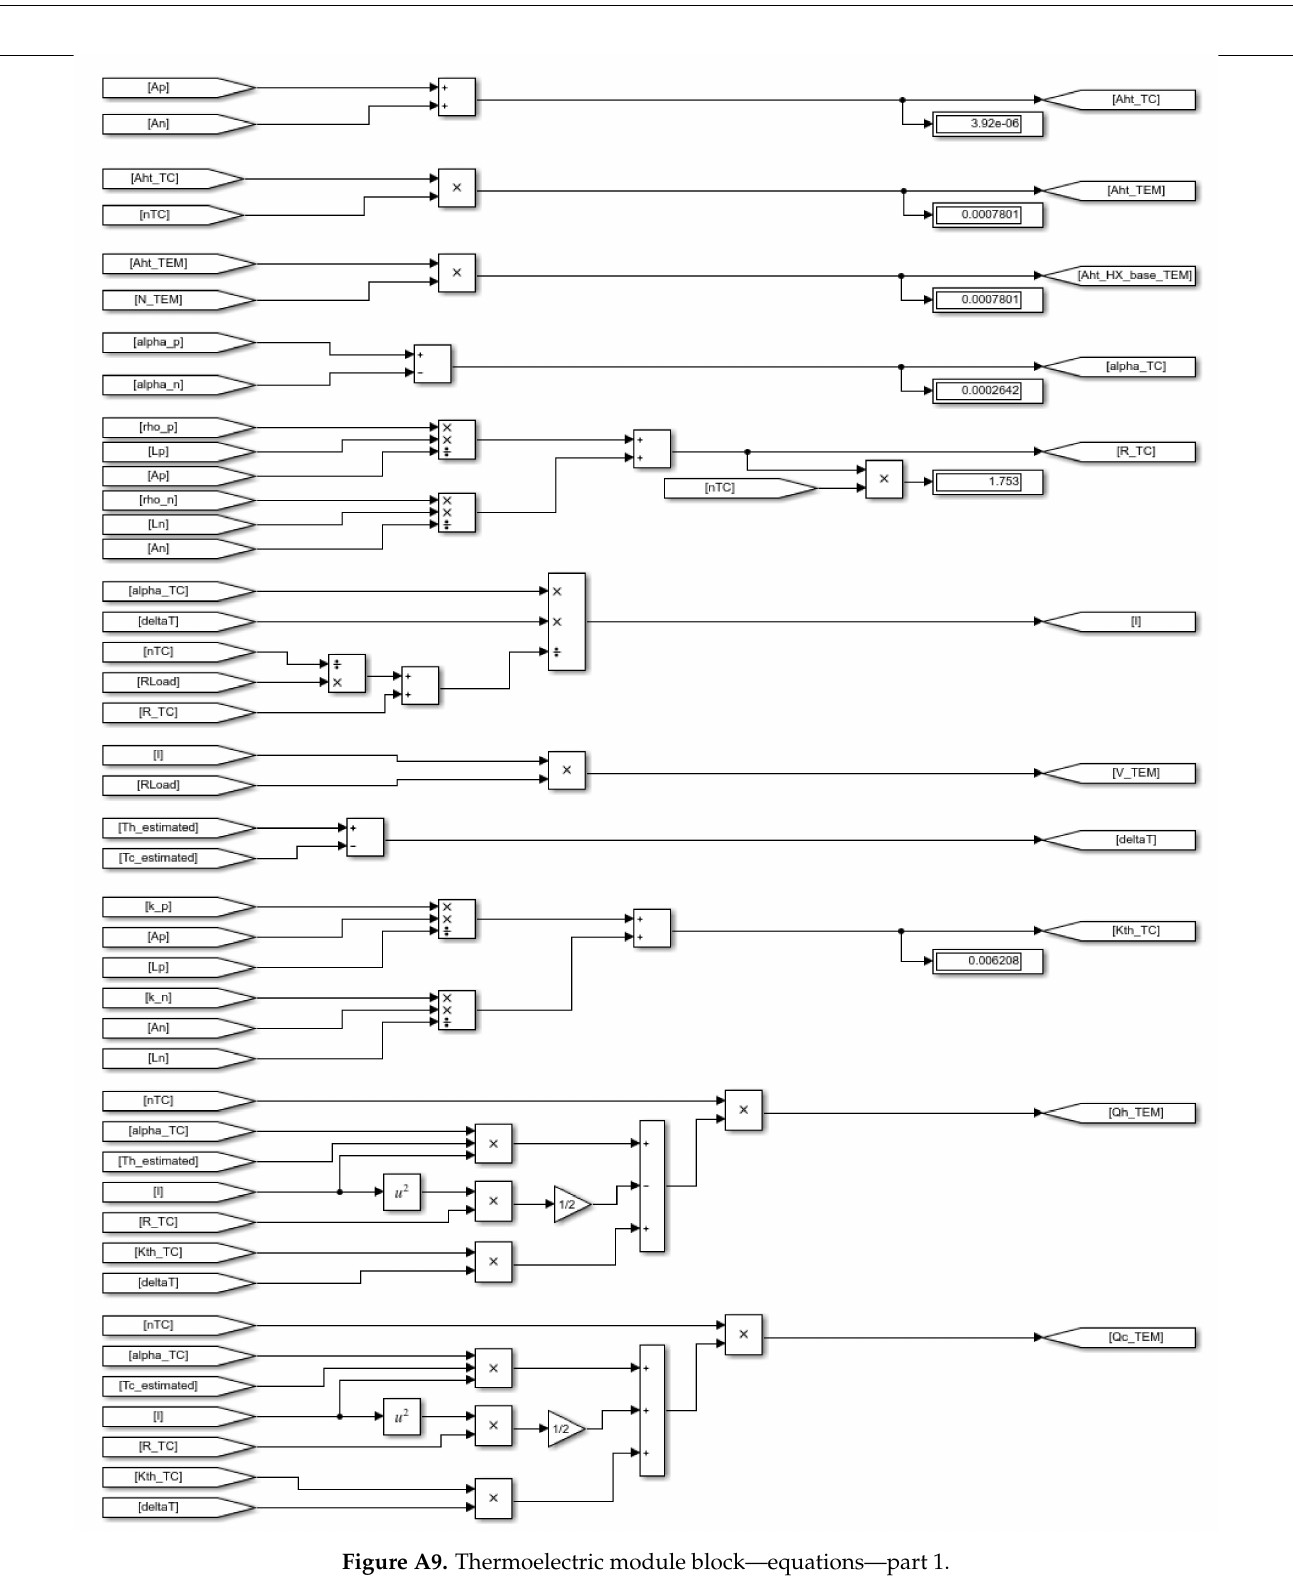
Figure A9. Thermoelectric module block—equations—part